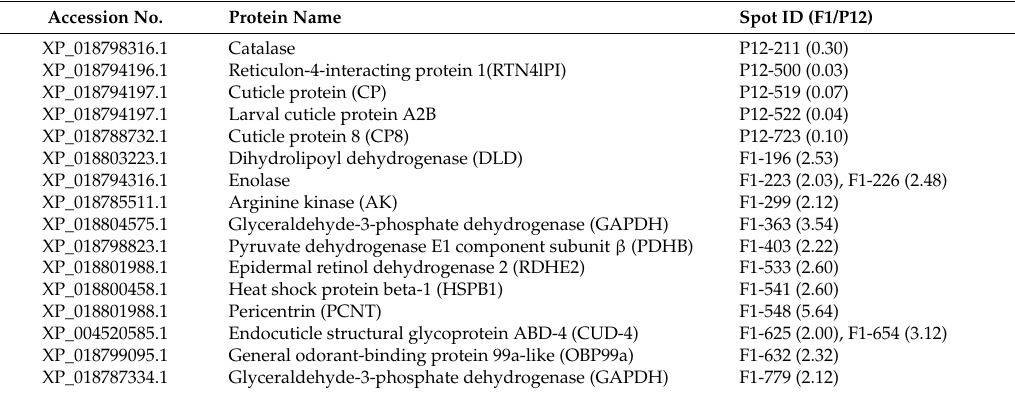
Table 3. Differentially expressed proteins between 1-day-old females (F1) (3A) and 12-day-old pupae (P12) (3B) of Bactrocera